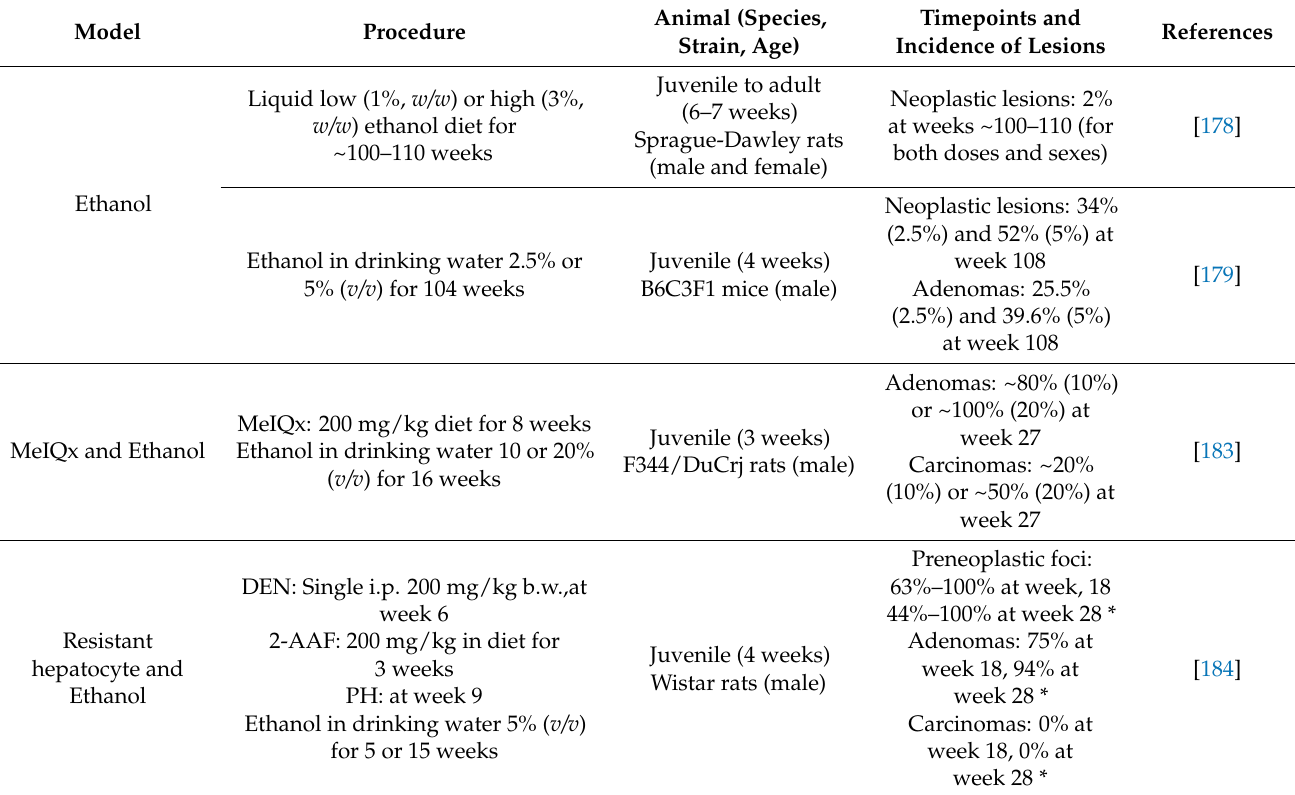
Table 4. Summary of the ALD-induced hepatocarcinogenesis protocols in